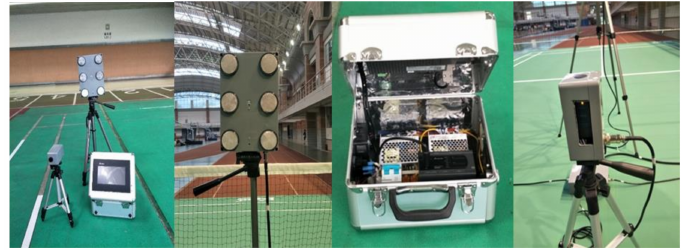
Figure 2. The badminton visual reaction system for badminton training and components.